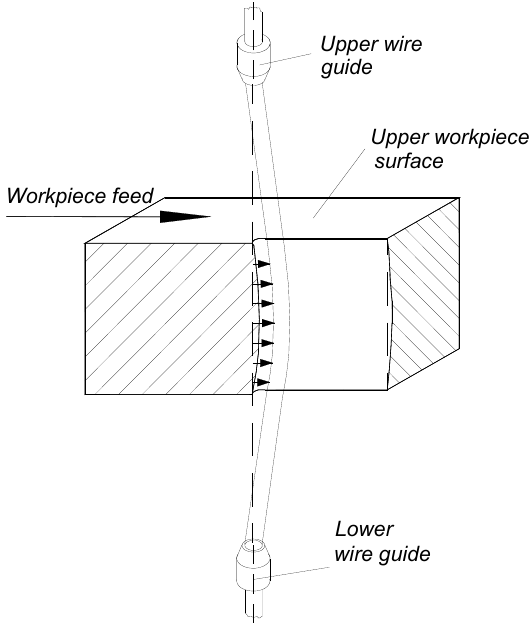
Figure 7. Redrawn figure of the wire tool deflection in the work zone during the WEDM process [72].